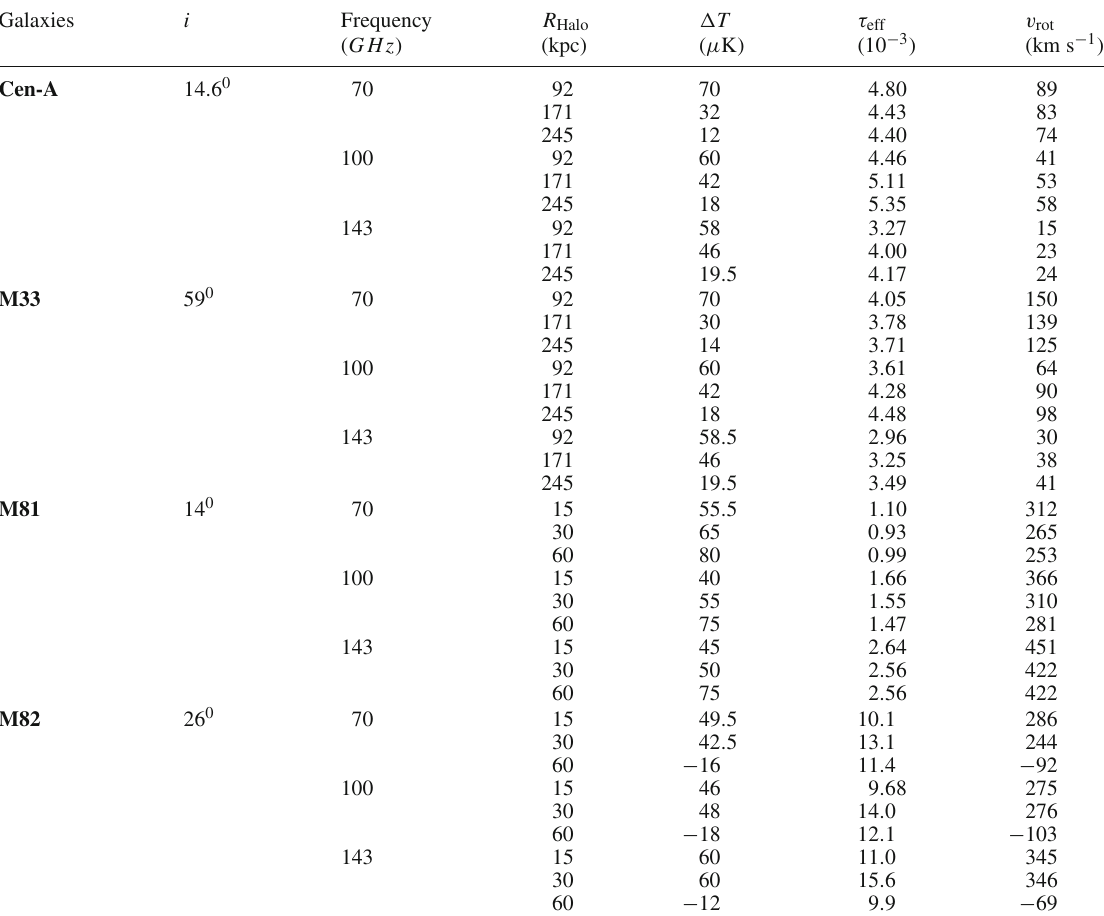
Table 2 Estimated effective optical depth and halo rotational velocity of the considered galaxies Galaxies i Frequency R